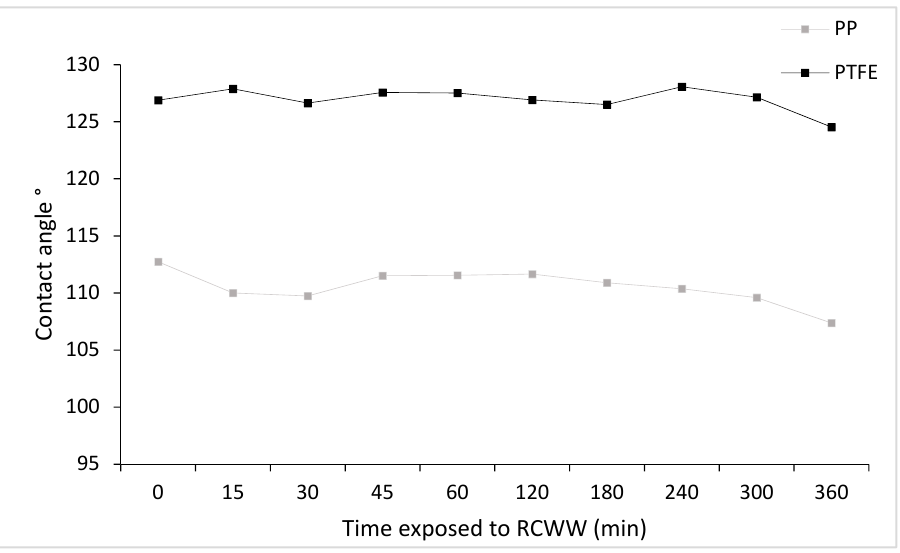
Figure 3. CA for membrane samples (PP & PTFE) exposed to RCWW at di ff erent time intervals. Table 2. LEP values obtained for PP and PTFE samples exposed to RCWW at di ff erent time intervals.